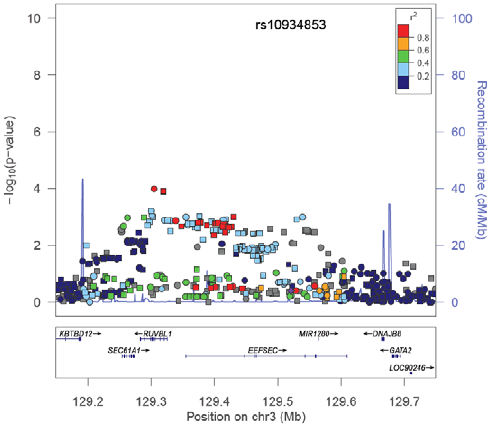
Figure 2. 2 Log P Plot for Common Alleles at the Chromosome 3q21 Prostate Cancer Risk Locus. The index signal (rs10934853) is designated by a purple diamond. The r 2 shown is that in Europeans from HapMap (CEU) in relation to rs10934853. 2 Log P-values are those observed in African Americans from logistic regression models adjusted for age, study, global ancestry (the 1 st 10 eigenvectors) and local ancestry. Circles are genotyped SNPs and squares are imputed SNPs. Grey circles are SNPs not in HapMap (r 2 can not be estimated). The plot was generate using LocusZoom [45].